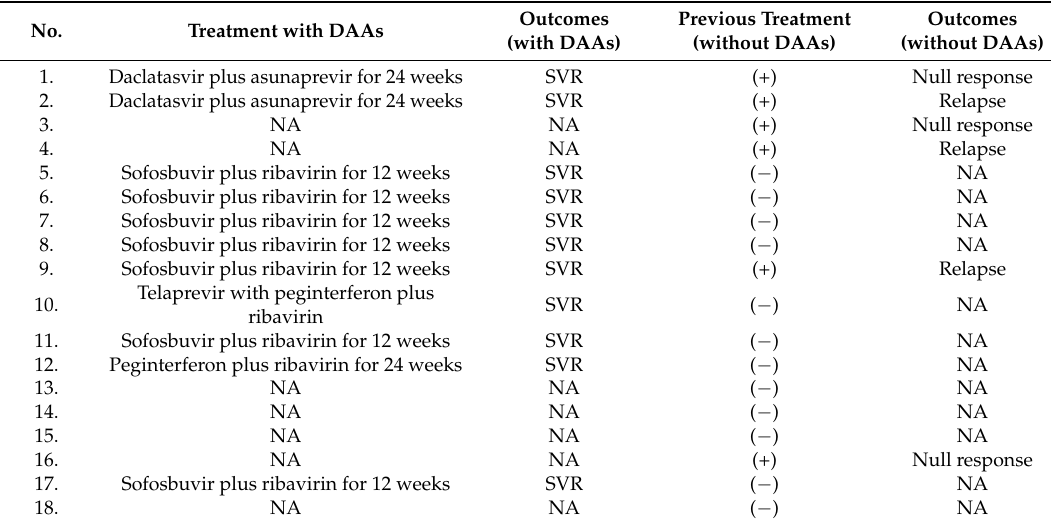
Table 7. Treatment outcomes with or without the direct-acting antiviral agents (DAAs) in the present